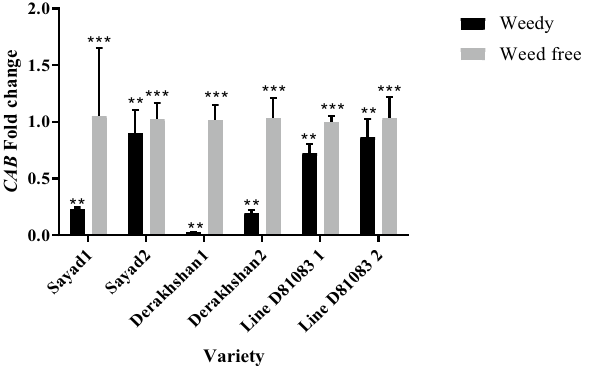
Figure 2. Real-time PCR (qRT-PCR) analysis of CAB gene transcript levels in two treatments weedy and weed free, in the three cultivars/lines studied and in two stages of sampling V4 and R7 (data are the mean ± standard error in five biological replications and five technical replications, numbers 1 and 2 next to the name of the cultivar represent the V4 and R7 stages, respectively). ***: P < 0.99; **: P <